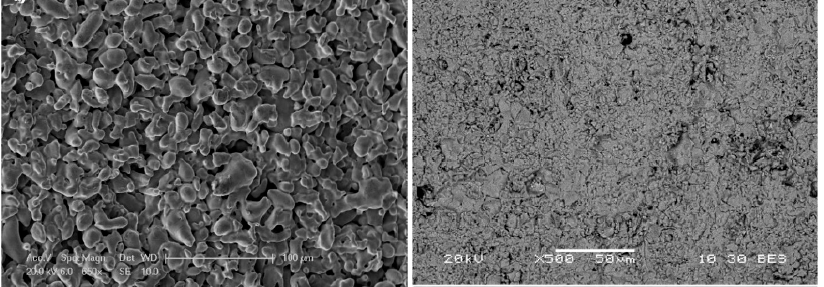
Figure 7. SEM images of original PSS support surface ( left ) and YSZ intermediate layer obtained with Nanox s4007 ( right ). Reprinted from [125] with permission from Elsevier.